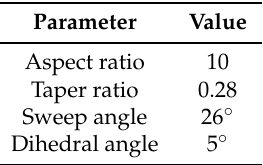
Table 6. Geometrical properties of the Embraer Benchmark wing.